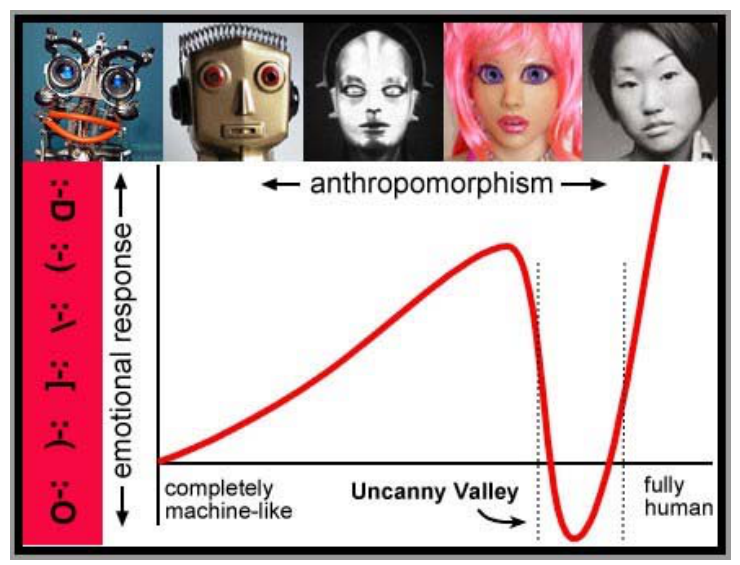
Figure 11. The uncanny valley. Source: www.umich.edu/~uncanny